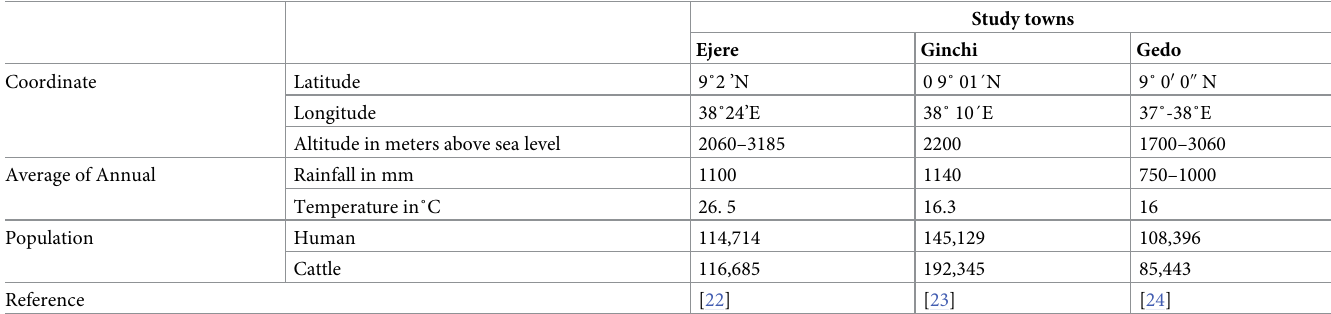
Table 1. Information about the study